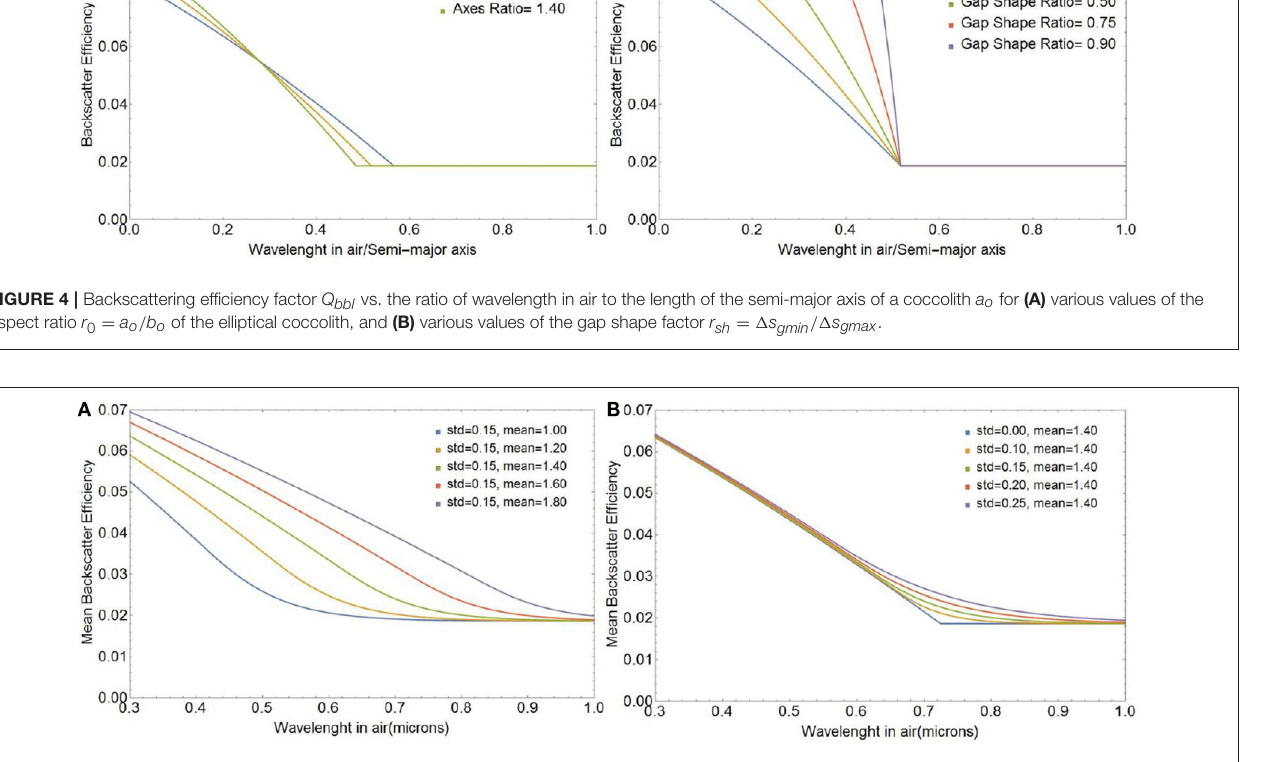
FIGURE 5 | Average backscattering efficiency for a second order shifted Gamma distribution of liths as a function of mean a 0 for a standard deviation of 0.15 (A) and as a function of standard deviation for a mean a 0 of 1.4 µ m (B) .